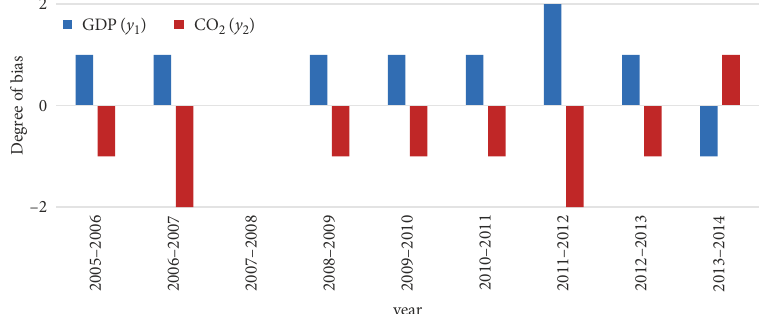
Figure 12. Order of output technological progress factors bias of the three major urban agglomerations Table 8. Order of output technological progress bias of each of the urban agglomeration Urban agglomeration Biased order Pearl River Delta